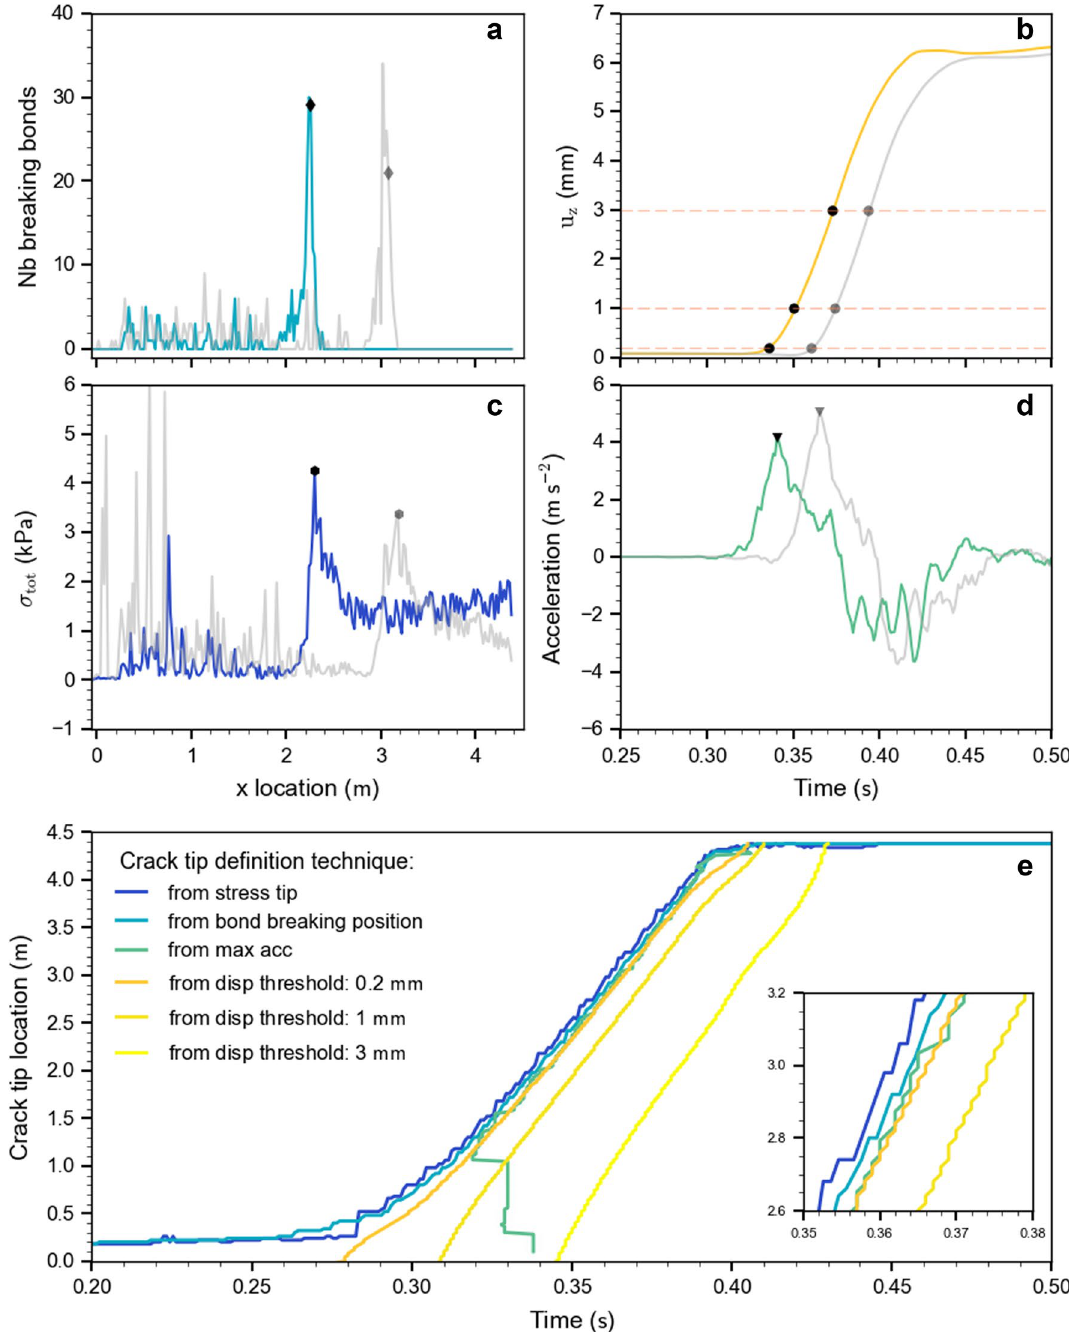
Figure 2. ( a ) Number of bonds breaking at a given time step along the length of the column; distributions for two different time steps shown (0.28 s and 0.3 s). ( b ) Temporal evolution of the normal slab displacement for two locations (x = 2 m and 3 m). The orange dashed horizontal lines correspond to three displacement thresholds (0.2, 1 and 3 mm). ( c ) Total stress along the length of the column at two different time steps (0.34 s and 0.36 s). ( d ) Temporal evolution of the slab normal acceleration for two x locations (at 2 m and 3 m). Markers show the position or time obtained to define the crack tip (in a , b , c , d ). ( e ) Temporal evolution of the crack tip position for different metrics of crack tip definition. ( f ) Inset shows zoom into the temporal evolution of the crack tip